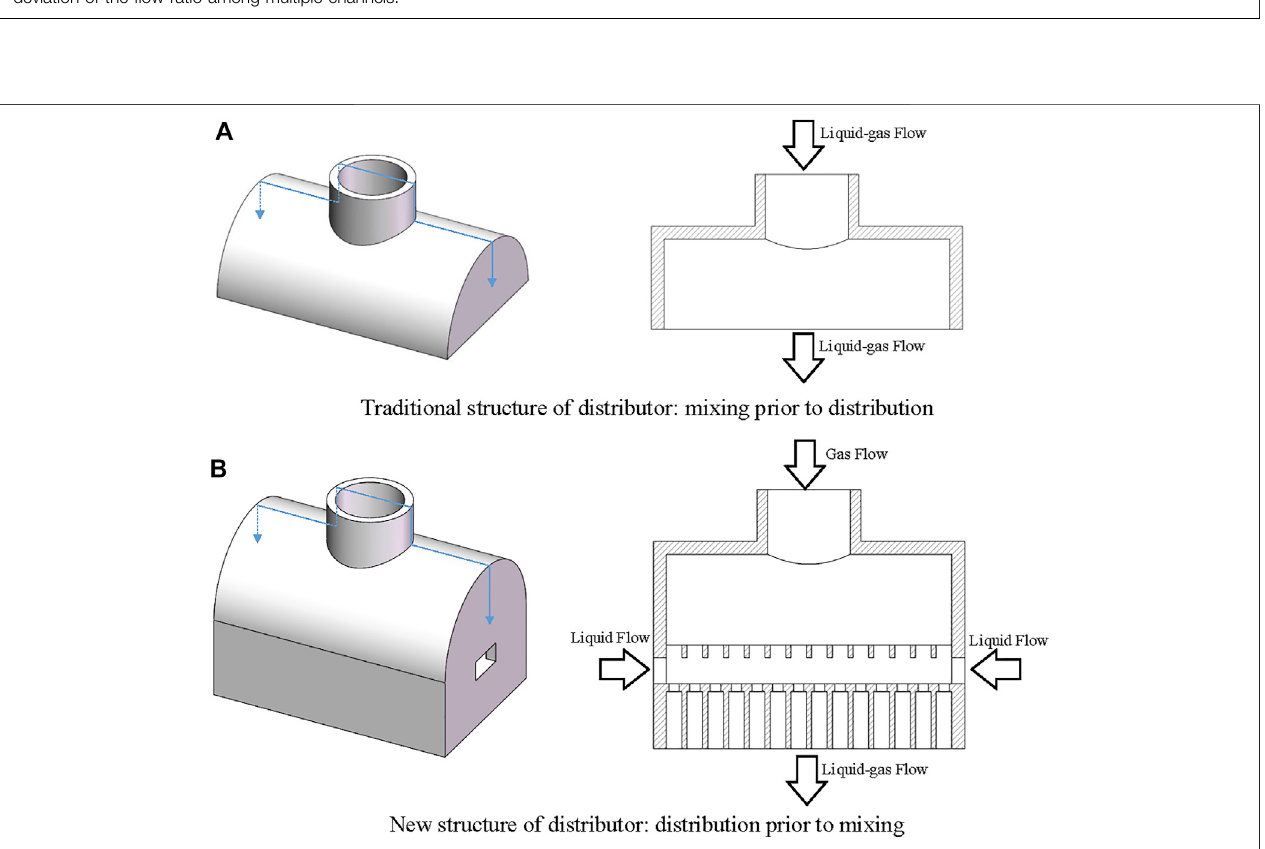
FIGURE 11 | Comparison of traditional and new structures of distributors (Yuan et al., 2016). (A) Traditional structure of the distributor: mixing prior to distribution. (B) New structure of the distributor: distribution prior to mixing.